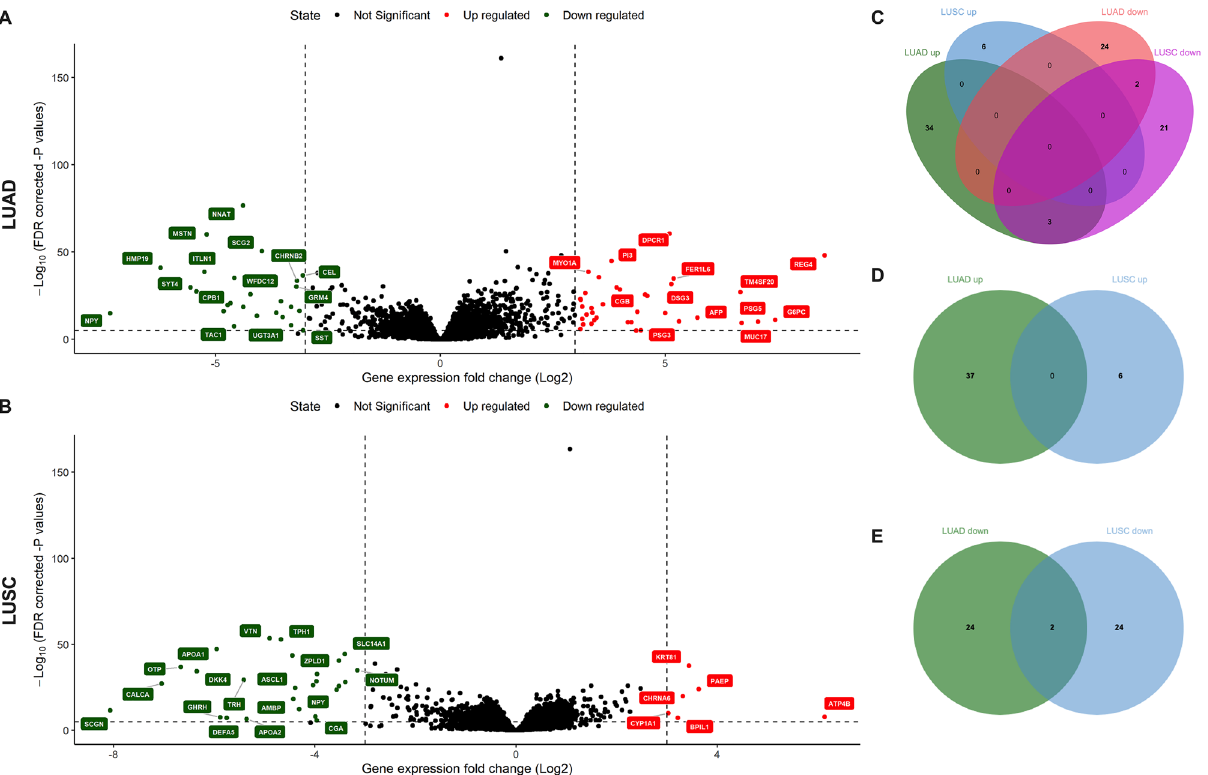
Figure 2. Volcano plots and Venn diagrams for differential expression analysis showing up- and down- regulated genes when MYO1E is overexpressed for LUAD ( A ) and LUSC ( B ) (FDR cutoff of 10^-5 and logFC of 3). Venn diagrams showing the overlap of genes between LUAD and LUSC for all genes ( C ), for upregulated genes ( D ) and downregulated genes ( E